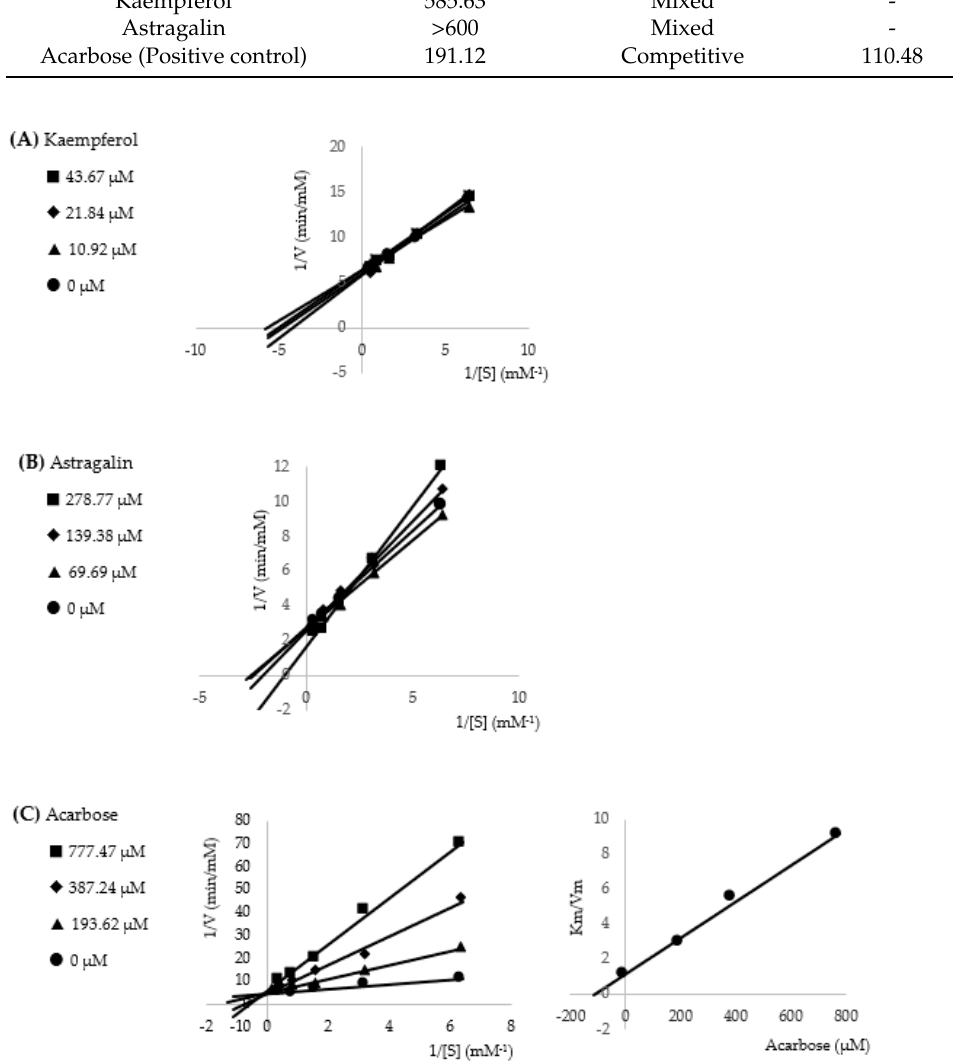
Figure 4. Lineweaver − Burk plots of kaempferol ( A ), astragalin ( B ). and acarbose ( C ). The secondary plot of acarbose is on the right.